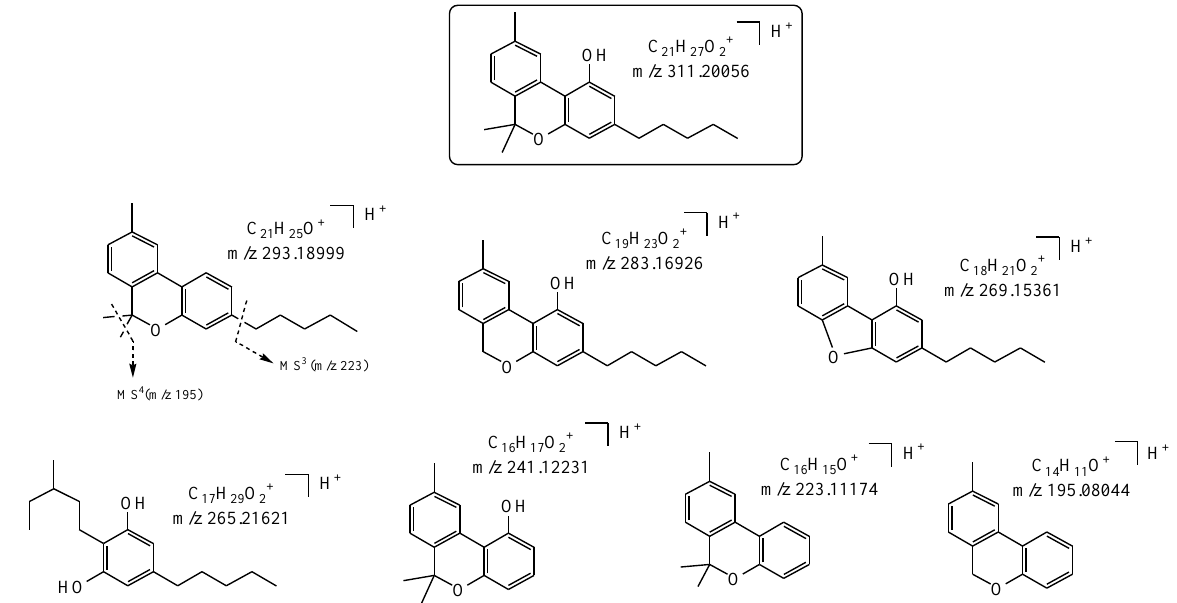
Figure 5. Proposed fragmentation structures for product ions of CBN, based on IRMPD-MS/MS spectra and CID-MS n .